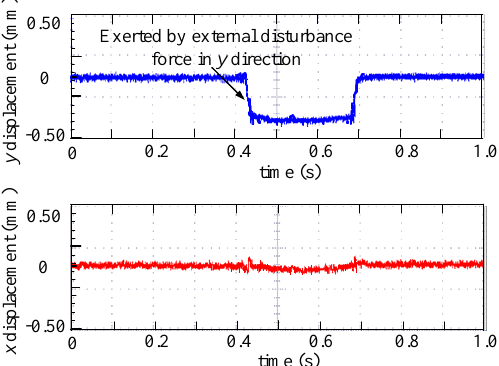
Figure 11. Waveforms of disturbance test in radial direction.